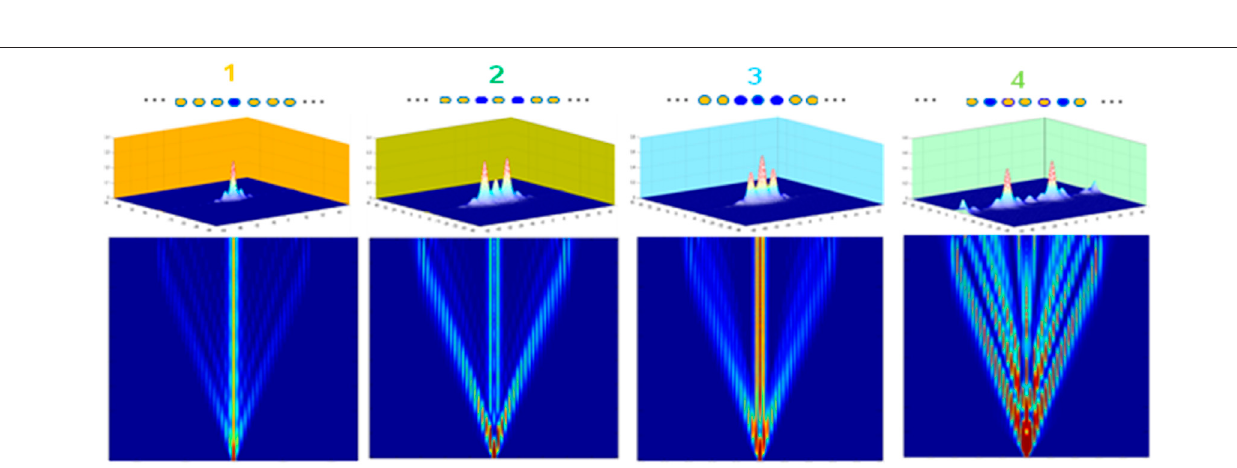
FIGURE 3 | From the top to the bottom : center of BPLs from left to right A 1 , A 2 , A 3 , and A 4 , center of photon distribution from these BPLs, top-view of light propagation in these BPLs. Centers of photon distribution from BPLs resemble the binary representation of corresponding numbers.